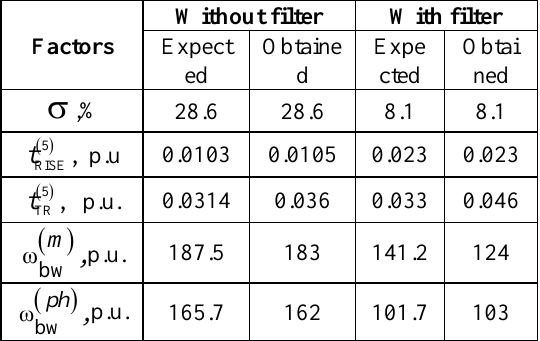
Table 3. Dynamic quality factors of closed speed loop